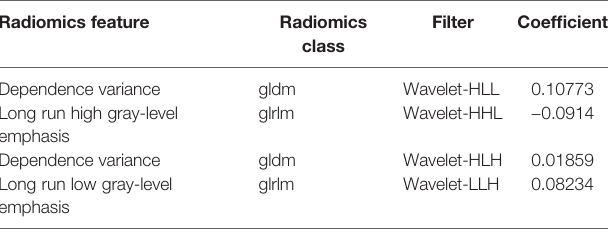
TABLE 2 | Description of the selected radiomics features with their associated feature group and fi lter in portal venous phase.